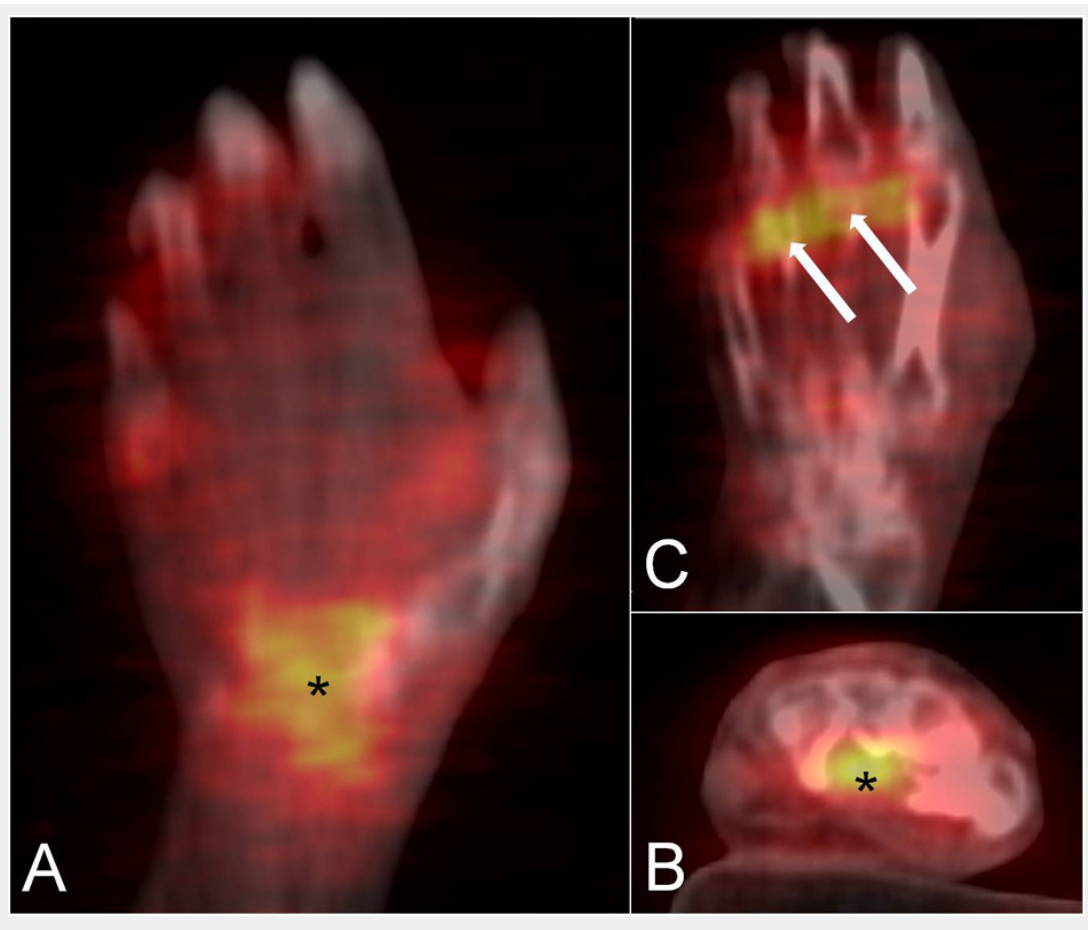
Figure 3 The coronal (A) and axial (B) PET/CT fused images of the wrist in a patient with rheumatoid arthritis demonstrate a focal area of F18-FDG uptake in the carpal tunnel, suggestive of flexor tendons tenosynovitis (asterisk). Tracer uptake is also observed in the metacarpophalangeal joints (C,